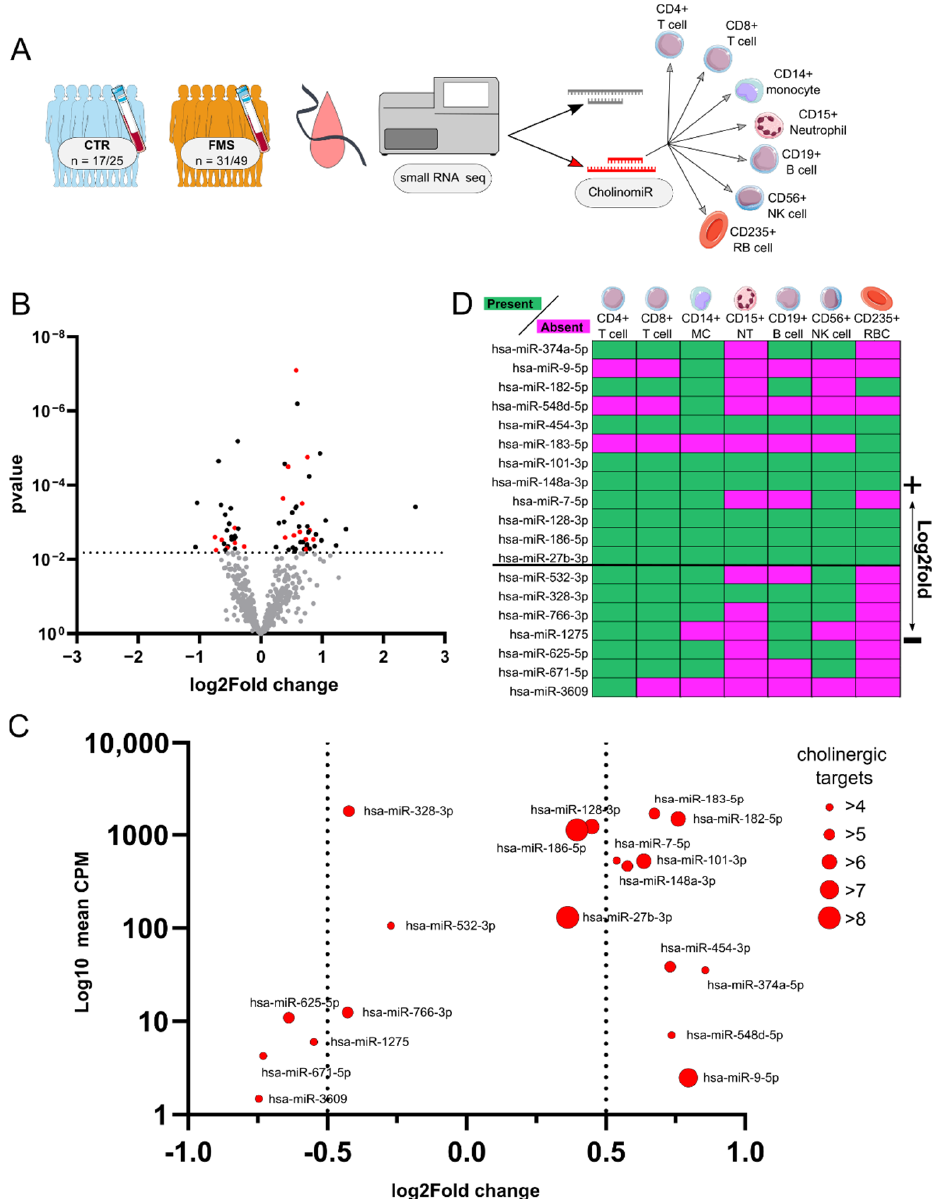
Figure 2. Small RNA-sequencing reveals 19 DE blood CholinomiRs in female FMS patients. ( A ) Blood collected in Tempus tubes from female FMS patients and matched controls was used for small RNA-sequencing and miR analysis. ( B ) Volcano plot of altered miR levels in FMS normalized to CTR, and the horizontal line indicates FDA-corrected threshold for DE miRs. Unchanged miRs are in grey, DE miRs are in black, and DE CholinomiRs are in red. ( C ) Counts per million of respective CholinomiRs and log2Fold change compared to CTR. Diameter of dots code for the number of predicted cholinergic targets. ( D ) Assignment of CholinomiRs to blood cell subtypes; magenta indicates absence, and green indicates presence in blood cell type according to [55]. Abbreviations: CholinomiR, cholinergic-targeting microRNA; CPM, counts per million; CTR, healthy controls; DE, differentially expressed; FDA, false discovery rate; FMS, fibromyalgia syndrome; MC, monocyte; miR, microRNA; NK, natural killer cell; NT, neutrophil; RBC, red blood